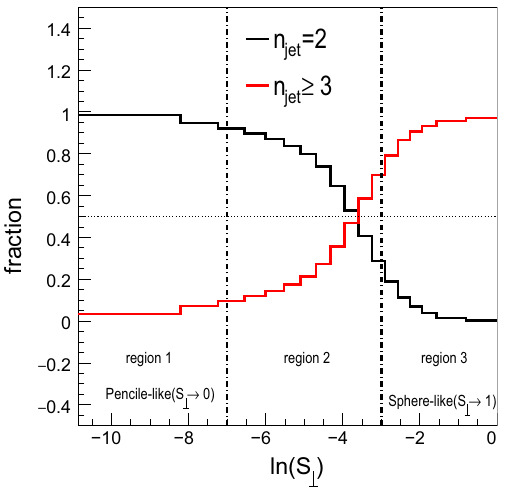
Fig. 5 Top: event normalized transverse sphericity distribution of n jet ≥ 3 events in p+p and Pb+Pb collisions at tom: medium modification factor of event normalized S ⊥ distribution of n jet ≥ 3 events